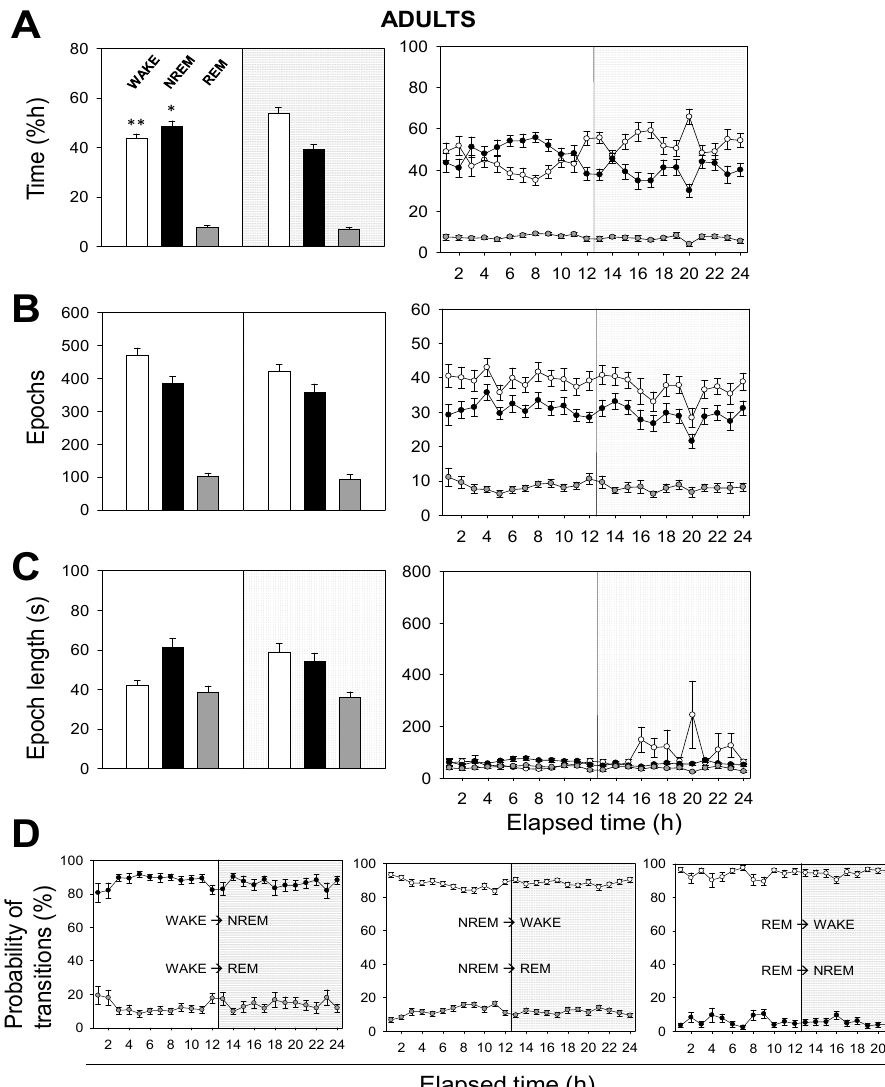
Figure 3. Sleep–wake characterization in adult mice. ( A ) Percentage of time spent, ( B ) total number of epochs, and ( C ) epoch length. White, black, or gray bars represent wakefulness, NREM, or REM sleep states, respectively. Parameters in ( A – C ) are calculated during a total of 12 h-light (white background) or 12 h-dark (gray background) phases (left panels) or across the recording time within the 24 h period (right panels). ( D ) Probability of behavioral state transitions for every hour during the recording session (1–24 h.). Left panel: From wakefulness into NREM and REM sleep. Middle panel: From NREM sleep into wakefulness and REM sleep. Right panel: from REM sleep into wakefulness and NREM sleep. White, black, or gray circles represent wakefulness, NREM, or REM sleep states, respectively. Data shown as mean ± SEM of 27 recordings retrieved from 11 adult mice. Asterisks denote significant differences between neonatal and adult mice: * p < 0.05; ** p < 0.01; Two-way ANOVA and Tukey’s test for post-hoc analysis.